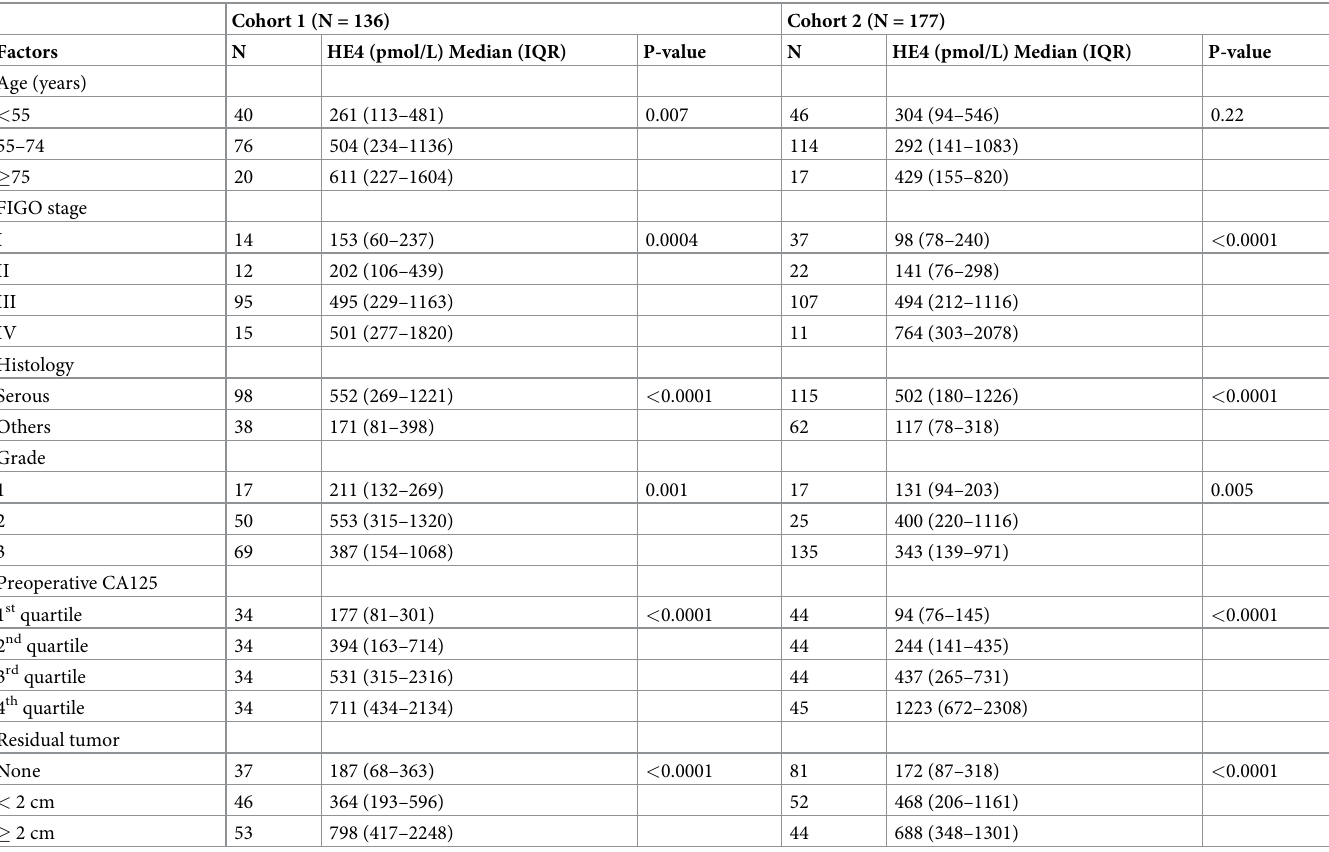
Table 2. Preoperative plasma HE4 levels according to standard prognostic factors in women with epithelial ovarian